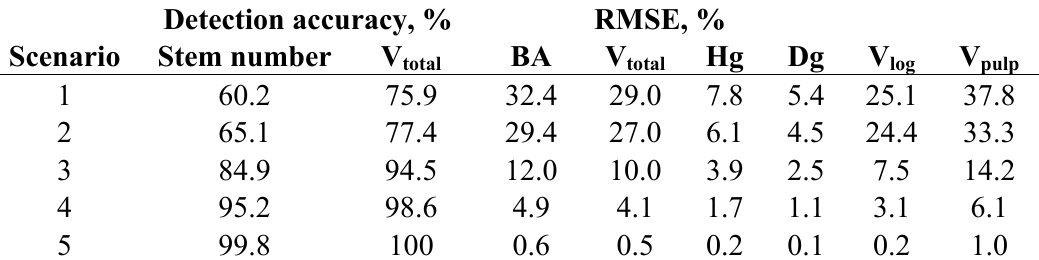
Table 2. Effect of tree